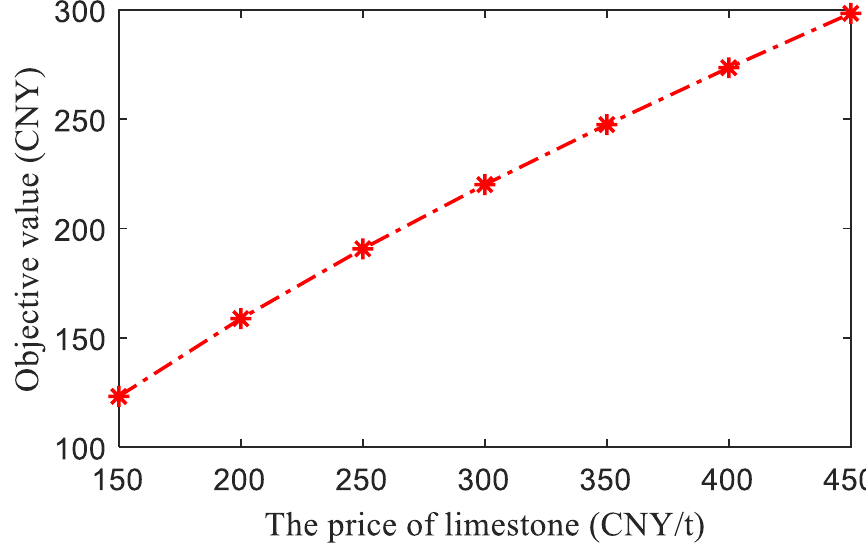
Figure 7. The relationship between limestone price and total cost.